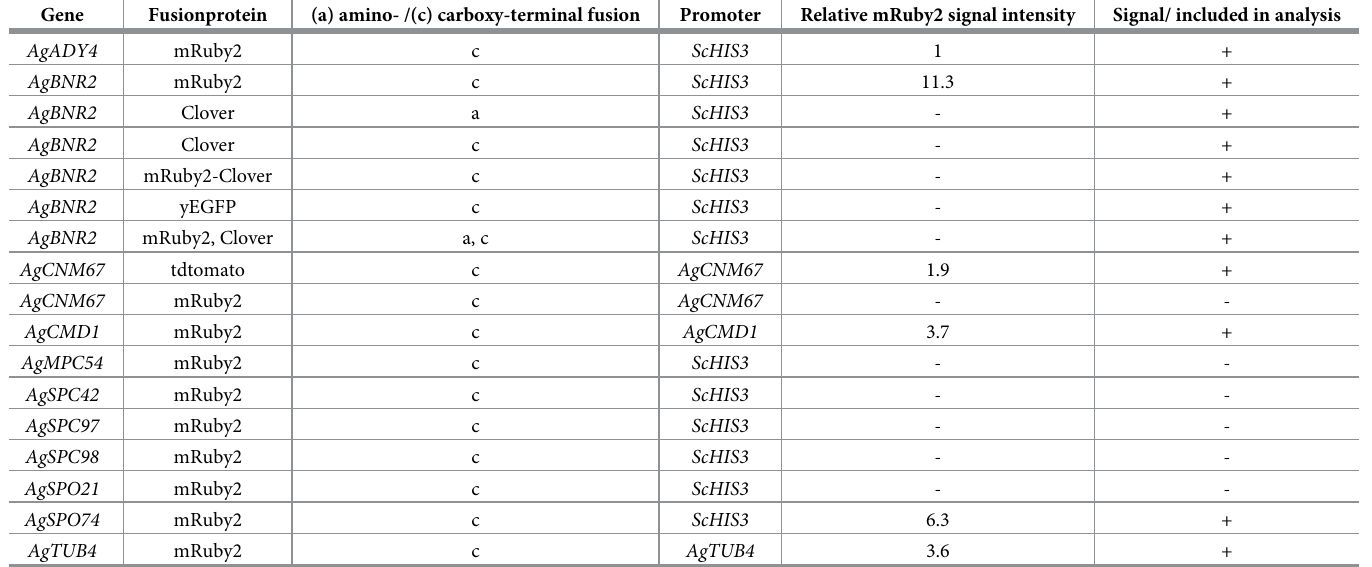
Table 2. Genes investigated for this study.